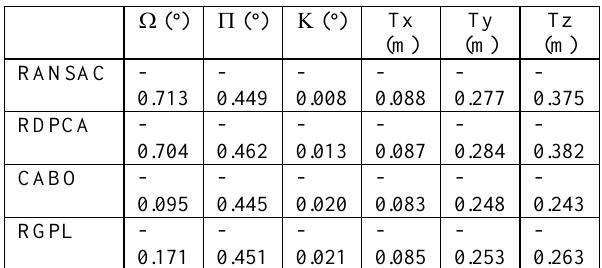
Table 7 RMSs after registration of four different approaches